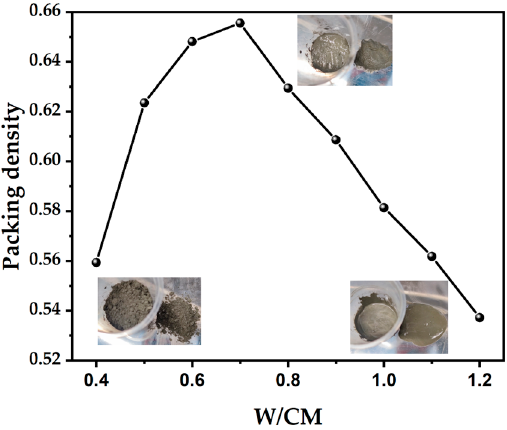
Figure 4. A schematic diagram of the applied wet packing density method.